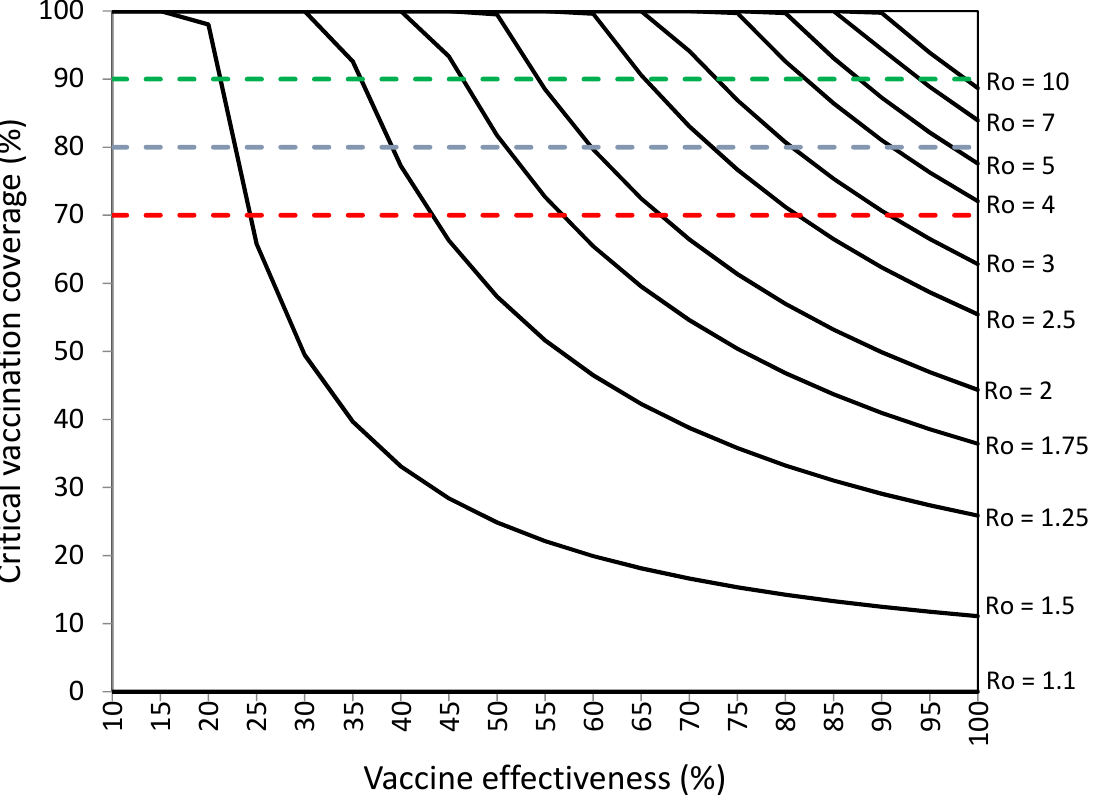
Figure 4. Vaccination coverage (%) required to establish herd immunity against SARS-CoV-2 with different basic reproductive numbers (R o ) by vaccination effectiveness (%) in a population with 10% prevalence of protected individuals and 9.8% of infections among vaccinated individuals. Objectives of vaccination coverage of 70%, 80%, and 90% are indicated with dashed red, blue, and green lines, respectively.